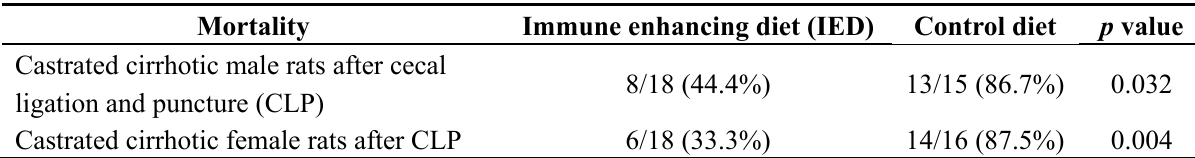
Table 3. Comparison of mortality between different diets in cirrhotic male and female rats after